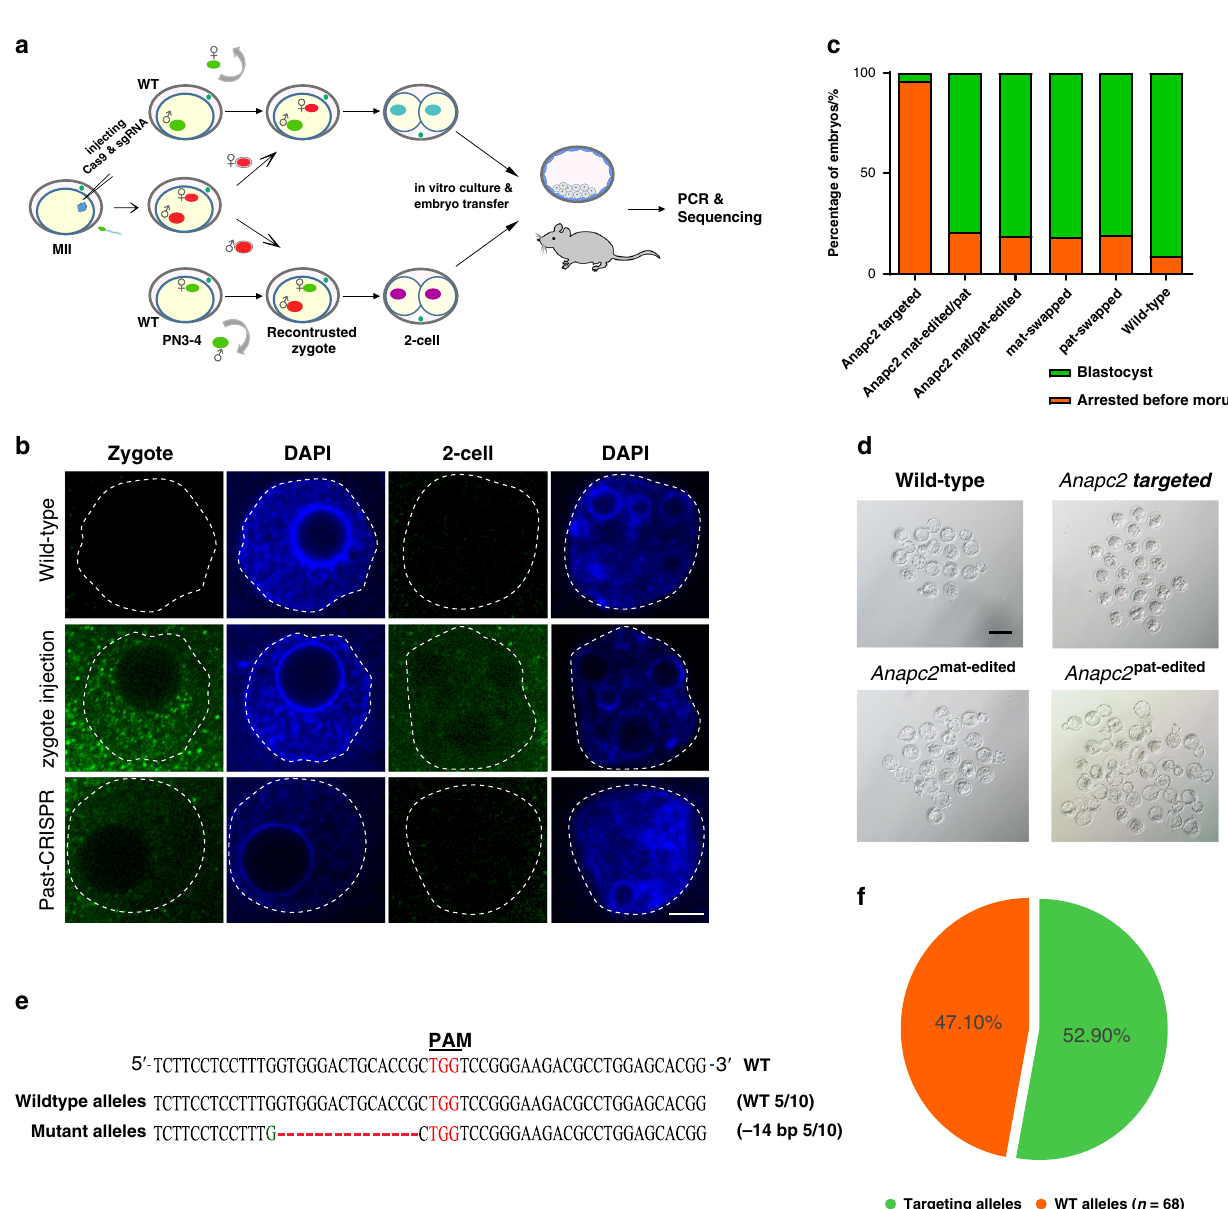
Fig. 1 The design and validation of parental allele-speci fi c site targeting methods. a A mixture of Cas9 and an individual sgRNA targeting Anapc2 was injected into MII oocytes. The injected oocytes and wild-type oocytes underwent IVF simultaneously. When the injected embryos developed into pronuleus PN3 – 4 stage 7 – 9 h post IVF, their paternal or maternal pronuclei (red ovals) were isolated and transferred into wild-type embryos with the maternal or paternal pronuclei (green ovals) depleted. The pronuclei were fused with the cytoplasm by the Sendai virus and generated reconstructed normal diploid zygotes. Some of the reconstructed embryos were transplanted into oviducts of pseudopregnant females, and others were cultured in vitro. Embryos and offspring were generated for PCR and sequencing. b Immunostaining for detecting SpCas9 signals in the nuclear region of zygotes and 2-cell embryos resulting from Past-CRISPR and traditional zygote injection. White dashed lines demarcate the nuclear membrane. The data shown are representative of at least two independent experiments. Scale bars, 5 µ m. c A bar graph shows the developmental potential (counted 96 h after fertilization) of Anapc2 -targeted embryos, Anapc2 mat-edited/pat embryos, Anapc2 mat/pat-edited embryos, and the wild-type groups (mat/pat-swapped wild-type embryos and wild-type embryos). d Bright fi eld images of Anapc2 -targeted embryos, Anapc2 mat-edited/pat embryos, Anapc2 mat/pat-edited embryos and wild-type embryos. One representative result of three independent experiments is shown. Scale bars: 100 µ m. e TA cloning sequences of the Anapc2 gRNA target sites from one of the potential parental allele-speci fi c edited embryos. Sequences of ten alleles present in individual embryos reveal two different types of alleles: half are wild-type alleles, and the other half are mutant alleles. f A pie chart demonstrates proportions of targeting alleles and wild-type alleles in the tested Anapc2 potential parental allele-speci fi c edited embryos. Number, total alleles including the gene Anapc2 , which enables differentiation of sequencing, and the results showed that 87% (13/15) of these the parental alleles (Supplementary Fig. 3a). Anapc2 potential blastocysts had monoallelic Anapc2 depletion (Supplementary paternal allele-speci fi c edited blastocysts and Anapc2 potential Table 3). More importantly, all the parental allele-speci fi c edited maternal allele-speci fi c edited blastocysts ( n = 15) obtained by sites in these monoallelic depleted embryos uniformly matched Past-CRISPR were assessed by PCR ampli fi cation and TA clone the respective parental SNP sites (Fig. 2a and Supplementary